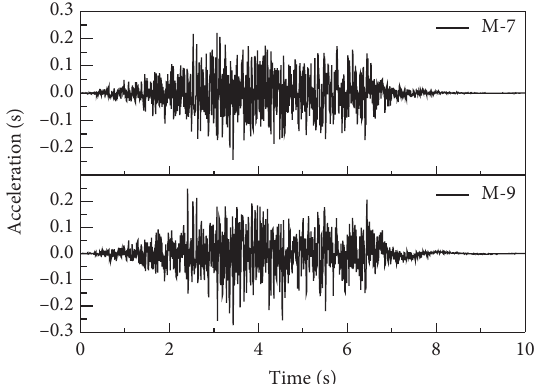
Figure 10: Synthetic artificial random multipoint excitation seismic